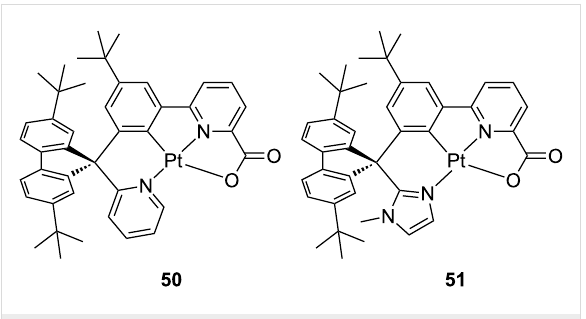
Figure 21: Chemical structure of the asymmetric tetradentate deriva- tives 50 and 51 based on spirofluorene linkage [96].